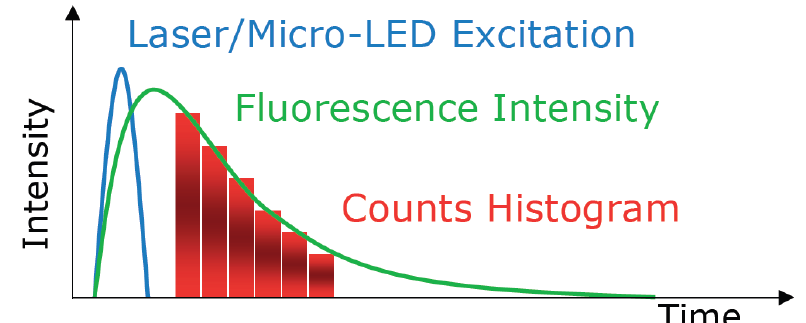
Figure 7. Illustration of a fluorescence lifetime decay captured using a time-gated counter